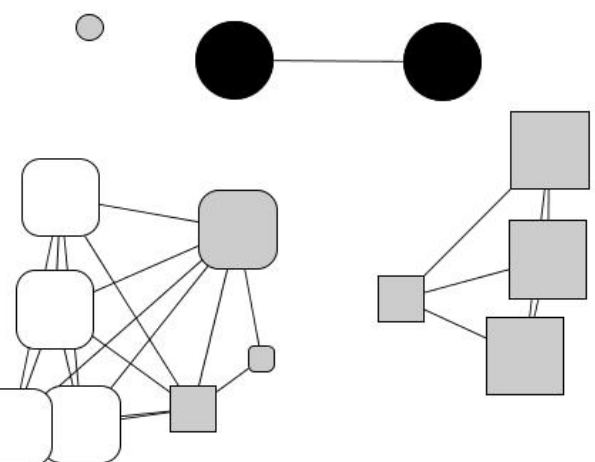
Figure 4. Julio’s personal network. Node color indicates type of relationship: family members (black), friends and acquaintances (gray), and professionals (white). Node size indicates ego’s perception of alter’s status: big size (ego perceives that “alter has a better socioeconomic situation than me”), average size (ego perceives that “alter has a similar situation as me”) and small size (ego perceives that “alter has a worse socioeconomic situation than me”). Node shape indicates time of relationship: triangle (less than 1 year of relationship), square (between 1 and 5 years of relationship), rounded rectangle (more than 5 years) and circle (lifetime).